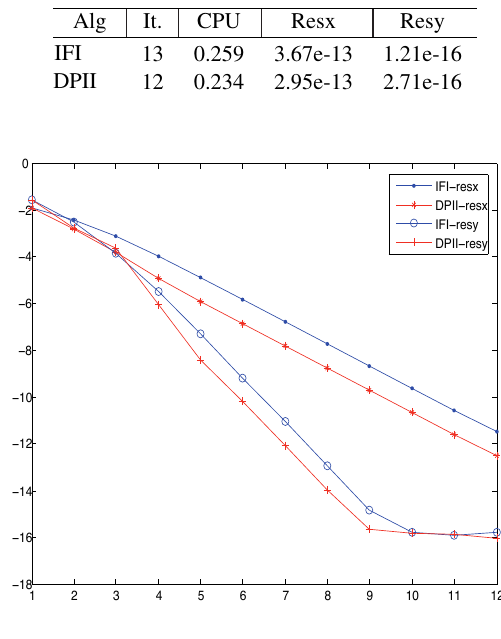
Fig. 3. Residual history for Example 3.